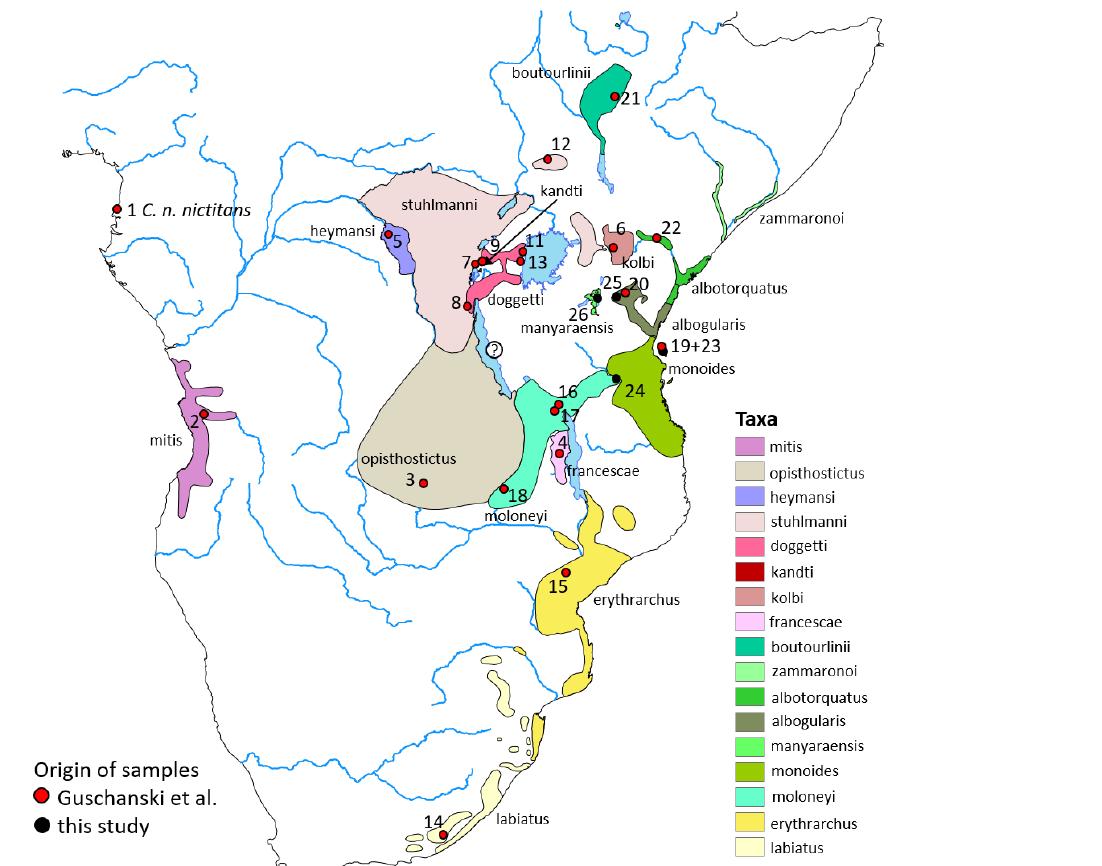
Figure 1. Approximate distribution of gentle monkey Cercopithecus mitis taxa based on the IUCN range map (updated from Butynski and de Jong, 2019, 2020). Cercopithecus m. francescae is no longer recognized by IUCN and is considered a synonym of C. m. moloneyi . The taxonomic status of C. mitis in the Mahale Mountains, central western Tanzania, is unclear (indicated by a question mark). Numbers refer to genetic samples from Guschanski et al. (2013) (red dots) or this study (black dots). The geographic origin of sample 10 is unclear (zoo animal) and is, therefore, not depicted on this map. See Table S2. Basemap by